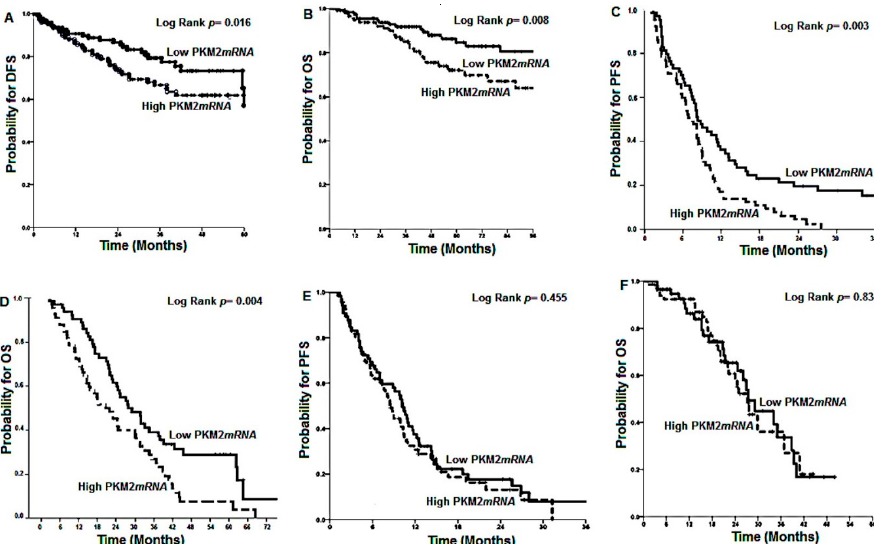
Figure 1. Kaplan Meier analysis in group A, group B, and group C colorectal cancer (CRC)